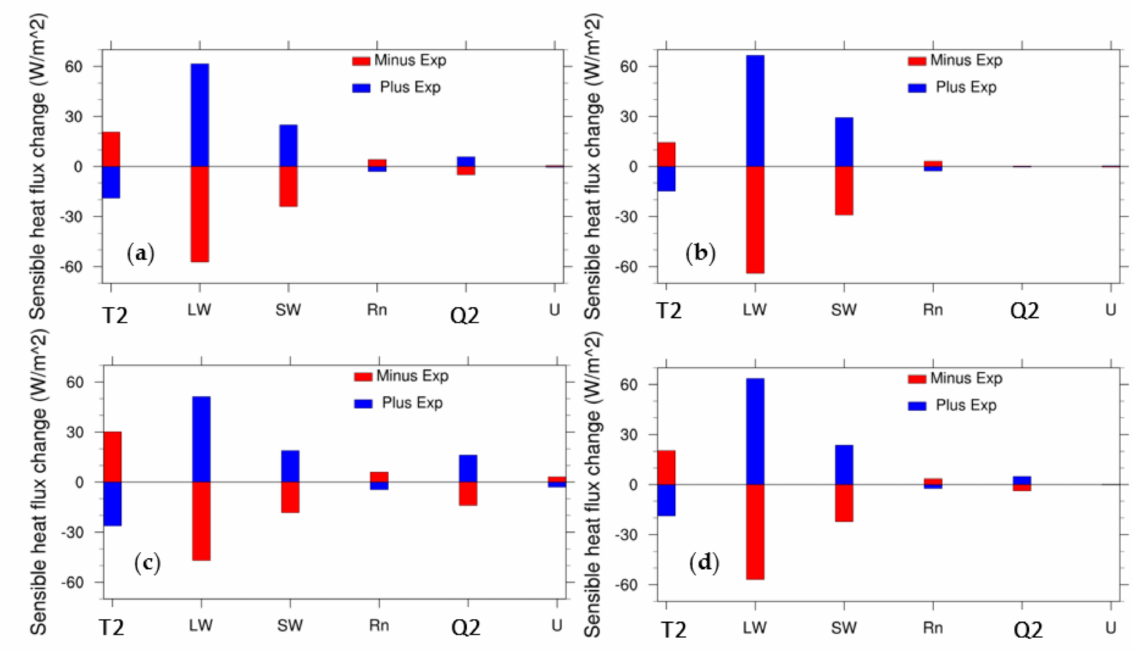
Figure 9. Sensible heat flux change (W/m 2 ) averaged over the Indian region from all the sensitive experiments. ( a ) Annual, ( b ) MAM, ( c ) JJA, and ( d )